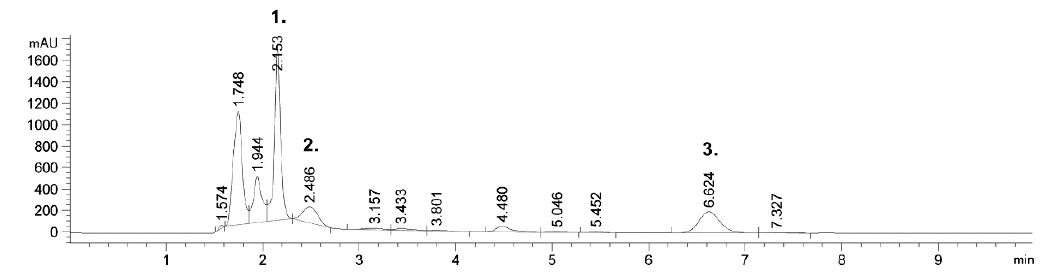
Figure 1. Chromatogram of phenolic compounds in scrap extract: Run 9.